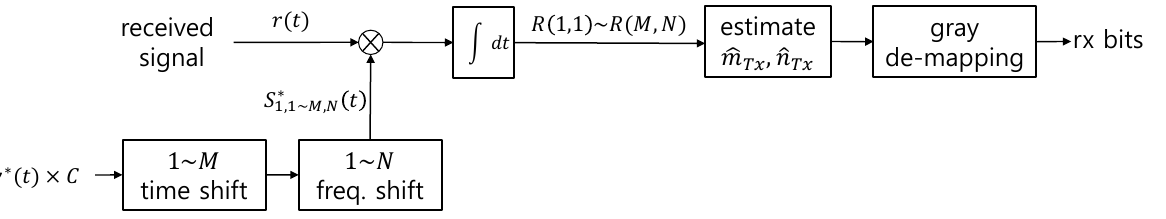
Figure 5. Block diagram of the proposed receiver.